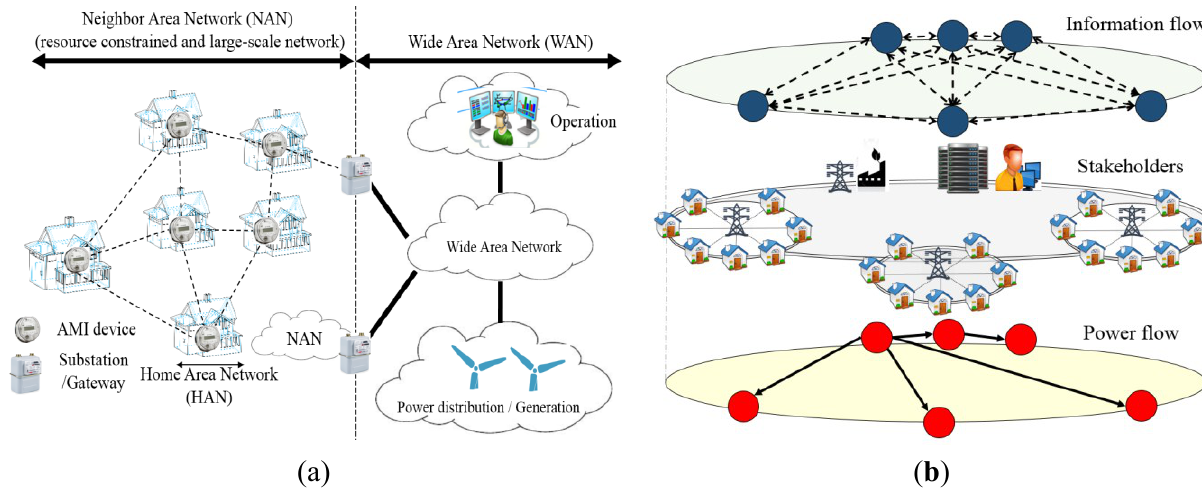
Figure 1. ( a ) multi-tier-based smart grid network architecture. ( b ) Abstraction of the information and power flow view of the smart grid